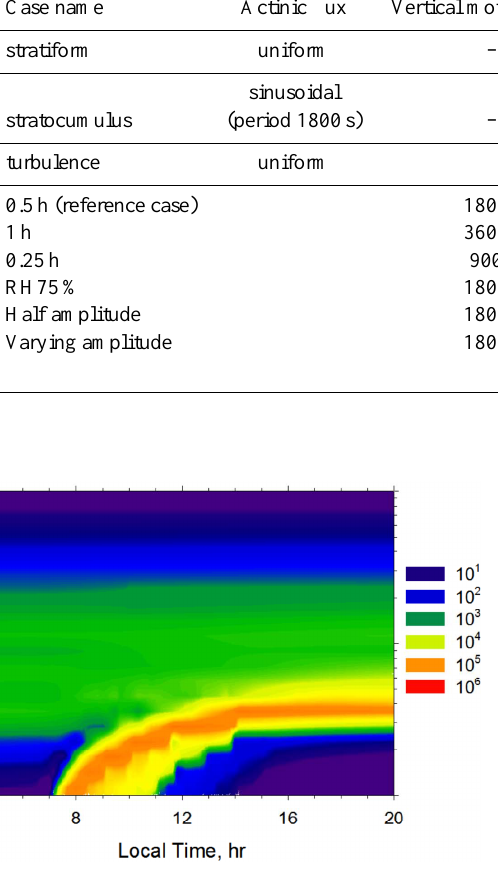
Fig. 5. Simulated evolution of aerosol size distribution correspond- ing to the St scenario in Fig. 4. The color bars show the particle number density (d N /dlog D) in cm − 3